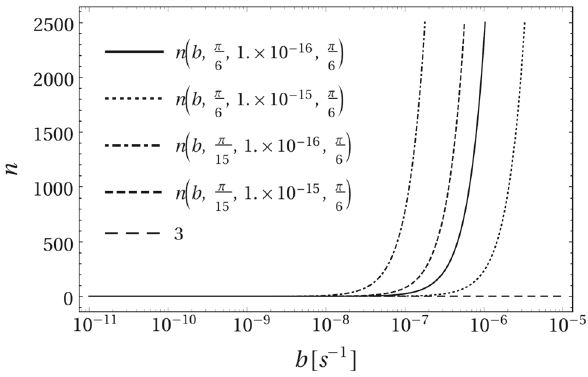
Fig. 4 The braking indices are functions of acceleration b for fixed magneticinclinationangle θ ,momentofinertia,magnitudeofmagnetic dipole and φ . The accelerations of pulsars are vertical to direction of rotation axes